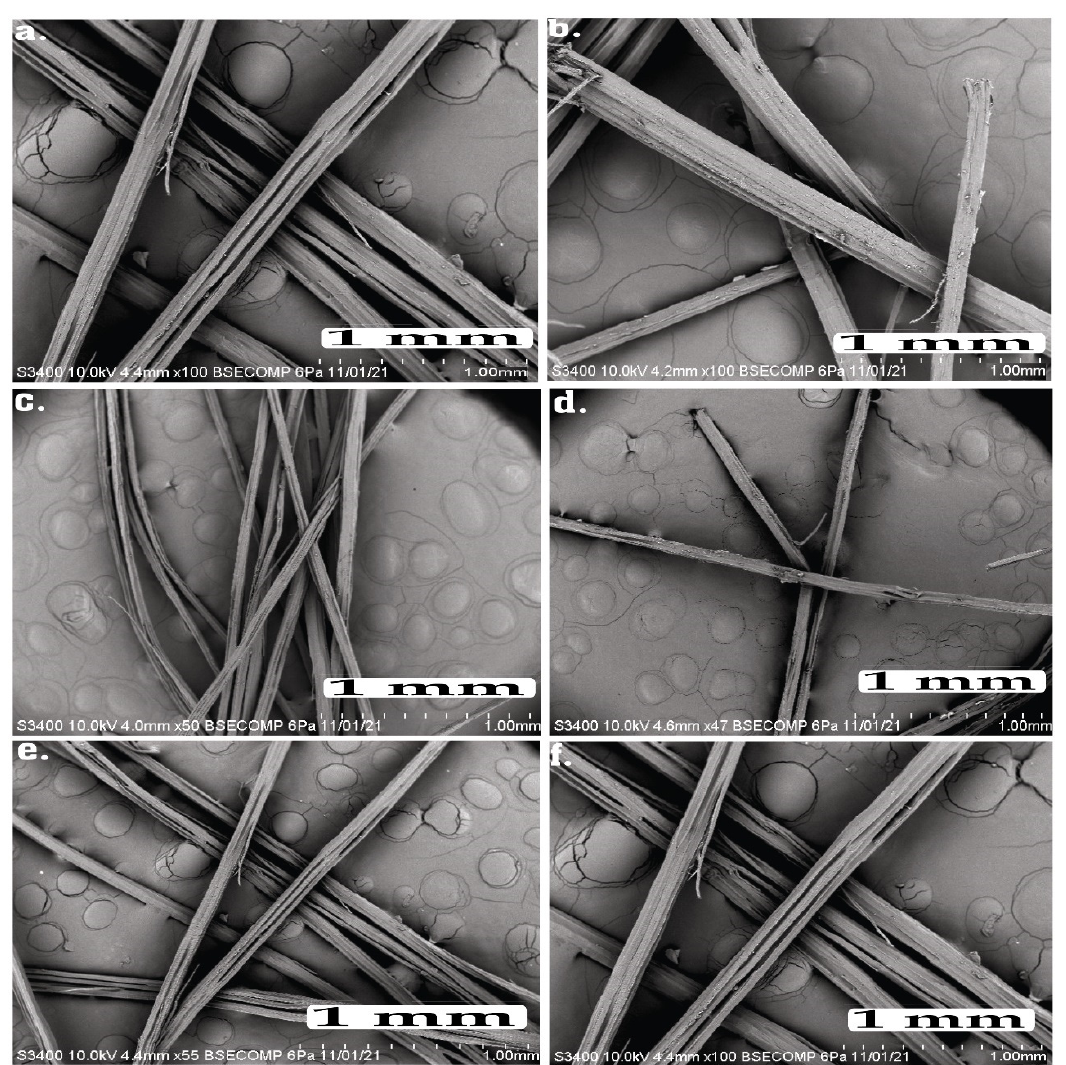
Figure 8. SEM images of the retted kenaf fibers at a 1 mm magnification, showing the fiber diameters. ( a ). Uninoculated with SW. ( b ) Uninoculated with FW. ( c ) APPB1 with SW. ( d ) APPB1 with FW. ( e ) APPB2 with SW. ( f ) APPB2 with FW.